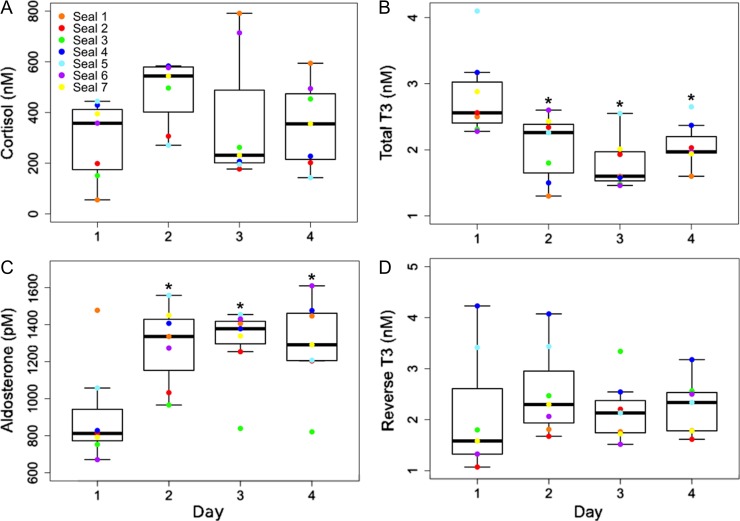
Hormone levels in samples collected prior to ACTH administration (0-h) on each day of the experiment. (A) Cortisol levels recovered to baseline (Day 1 0-h) within 24 h of each ACTH administration. (B) Total T3 0-h concentrations on Days 2–4 were suppressed relative to baseline (LMM: F3, 18 = 10.5, P < 0.0001). (C) Aldosterone 0-h levels on Days 2–4 were elevated relative to baseline (LMM: F3, 18= 8.06, P < 0.001). (D) Reverse T3 levels recovered to baseline within 24 h of each ACTH administration. *Denotes significant differences between 0-h hormone levels on Day 1 and subsequent days. Whiskers are within 1.5 standard deviations above and below the third and first quartile, respectively.